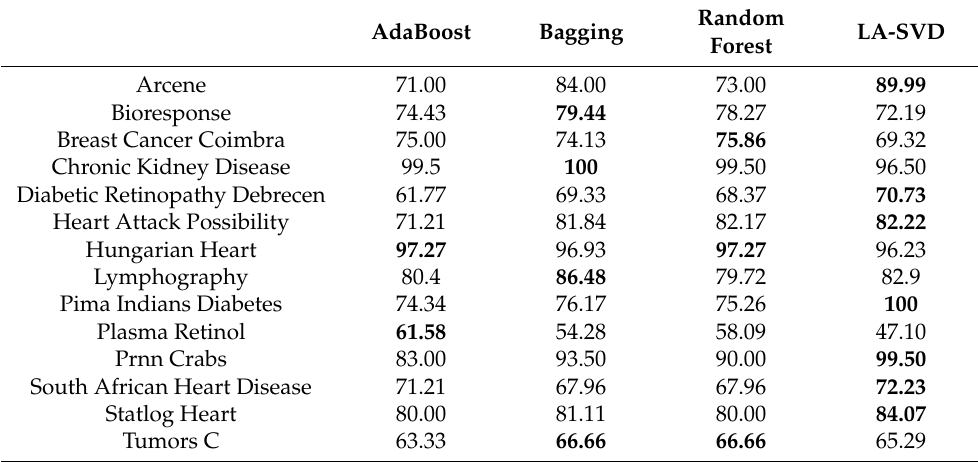
Table 9. Accuracy values (in %) exhibited by the LA-SVD algorithm and by three ensemble classifiers (best values in bold and framed).